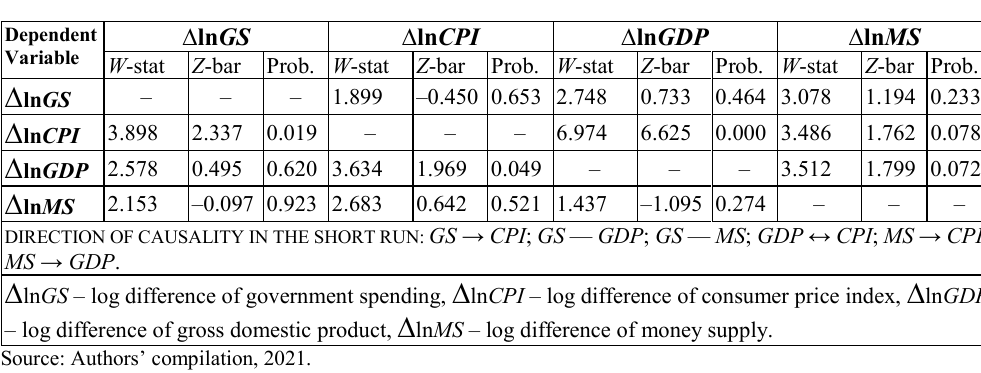
Table 7. Result of Short-Run